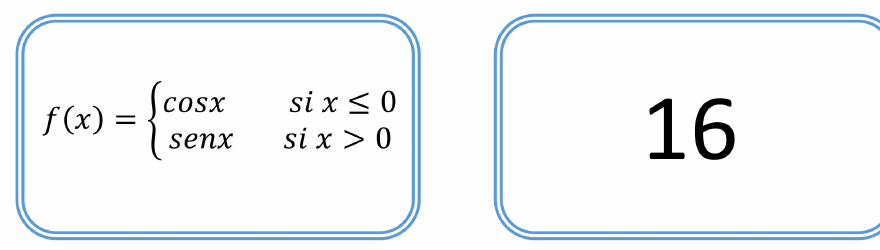
Figure 4. Image of an analytical game sheet.